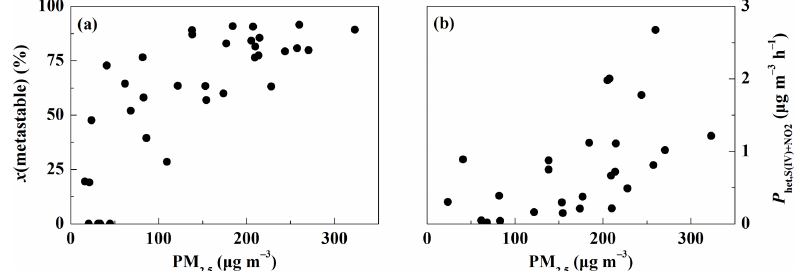
Figure 8. The estimated fraction of metastable aerosol to total aerosol ( x (metastable), a ) using Eq. (9) and heterogeneous sulfate production rate from S(IV) oxidation by NO 2 assuming a combination of metastable and stable states ( P het , S ( IV ) + NO + (100% − x (metastable)) × P x (metastable) × P het , S ( IV ) + NO het , S ( IV ) + NO 2 , stable 2 , metastable